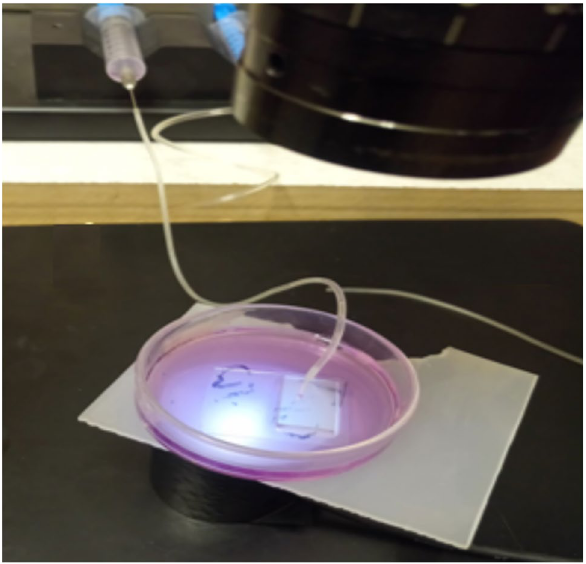
Figure 5. Connecting the syringe pump to the micro-channel and making stress via the 17-micron channel in